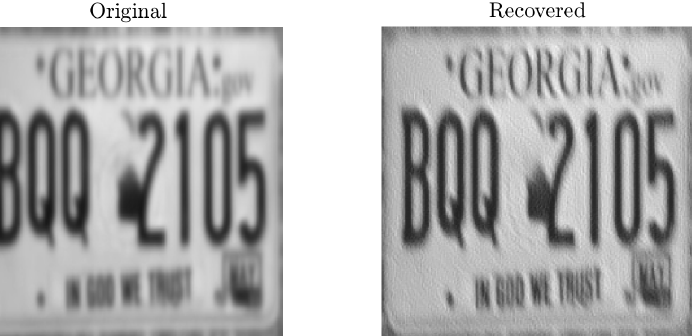
Figure 20. Result on deblurring an image that does belong to a training set of blurred